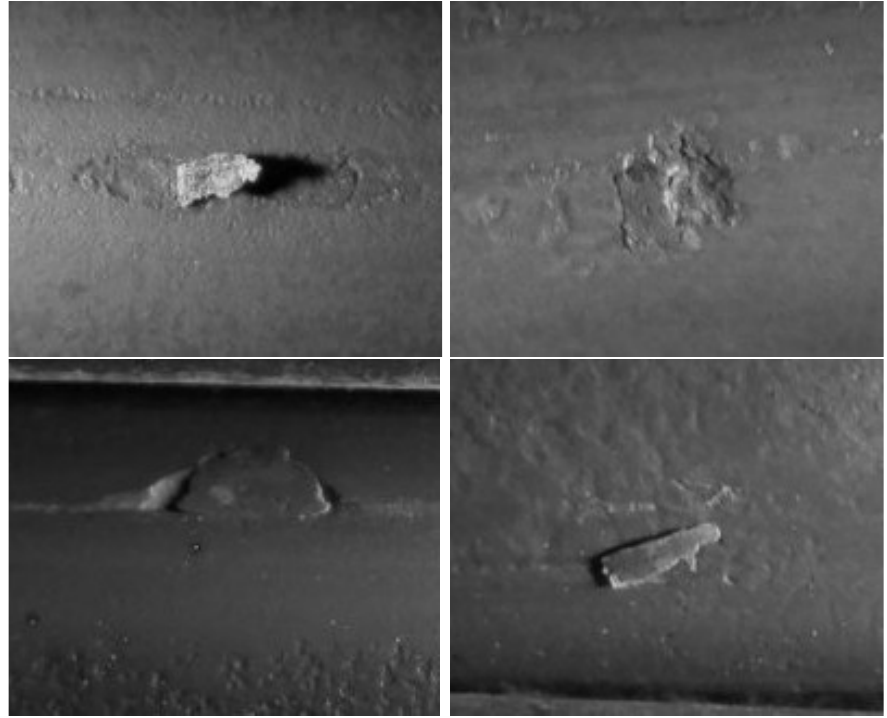
Figure 3. Macro photography of individual defects belonging to each